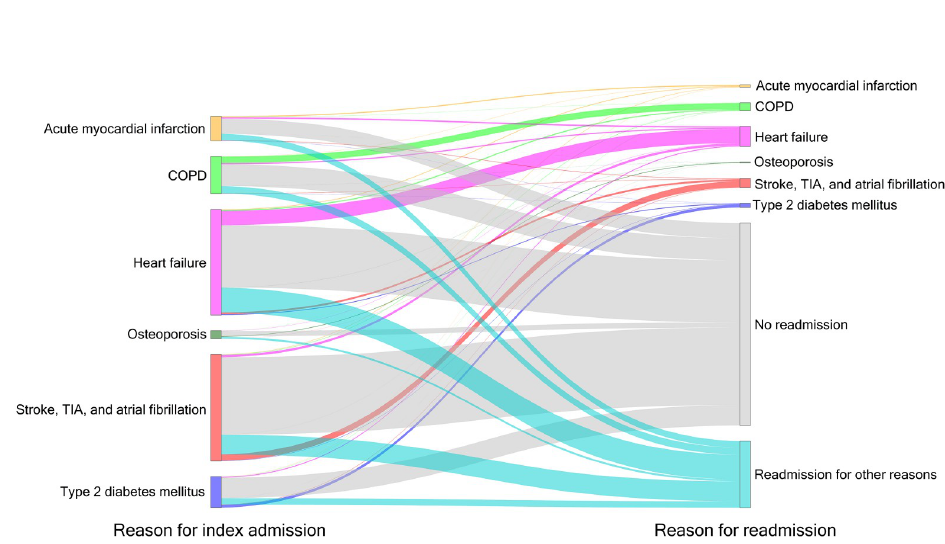
Fig 2. Sankey diagram of index hospitalization and subsequent readmission within 90 d. Colors were assigned to reasons for readmission and the width of the links between nodes (connection between reason for index admission and reason for readmission) and the heights of the nodes (different reasons for admission) indicate the number of corresponding index admission and readmission cases. Looking at cases with an index admission for “heart failure”, the largest proportion of cases was not readmitted (grey link), followed by readmission for other reasons (turquoise link), for heart failure (pink link). The smallest proportion of cases was readmitted for osteoporosis (dark green link).